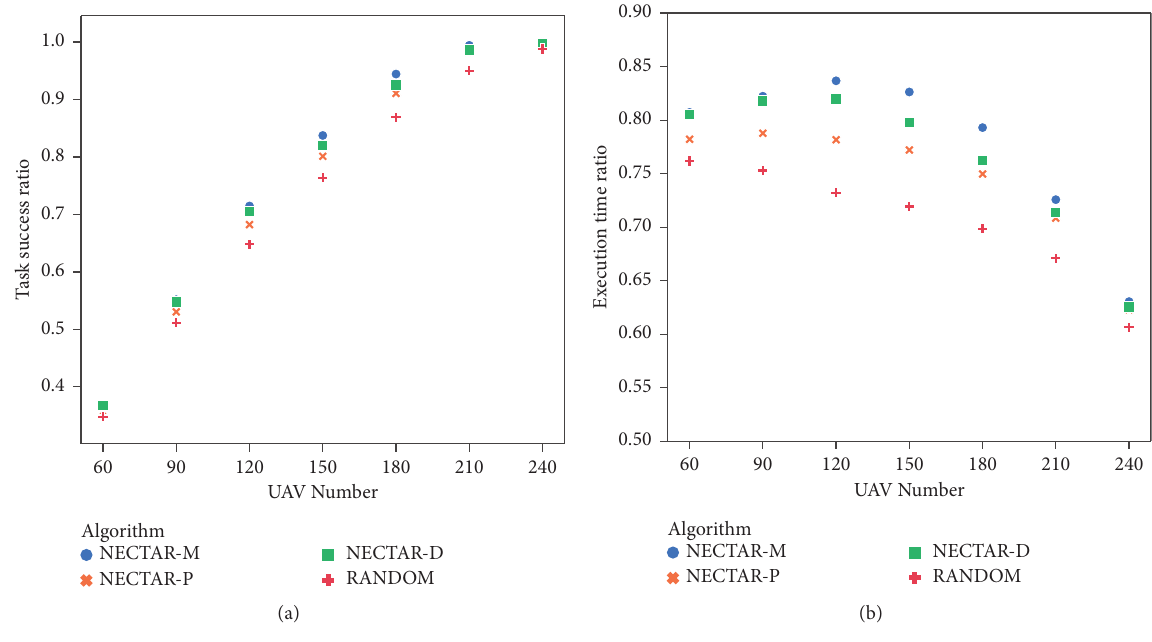
Figure 7: Performance impact of the UAV